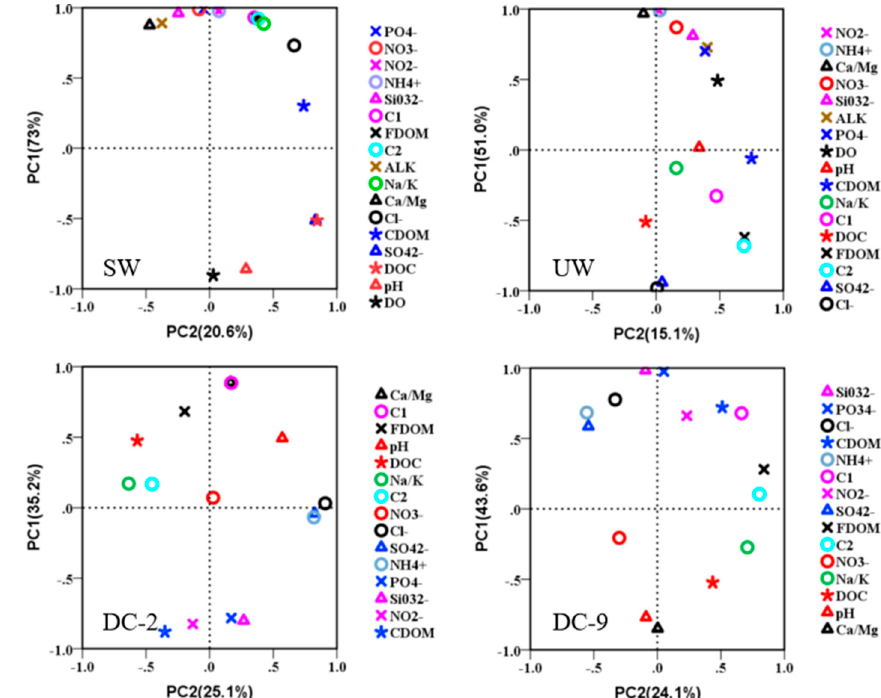
Figure 5. PC1 and PC2 loadings of DOM indices and environmental factors in surface (SW) and underlying (UW) pore waters at DC-2 and DC-9. PC1 and PC2 were obtained from principal component analysis. PC1: first primary component; PC2: second primary component.